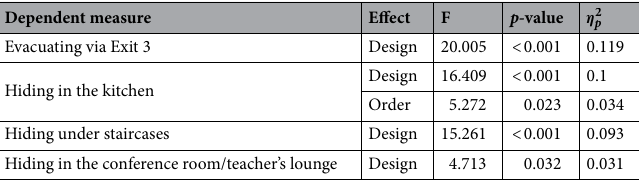
Table 3. Effects of design and order on participants’ choices (see Fig. 1 for the building